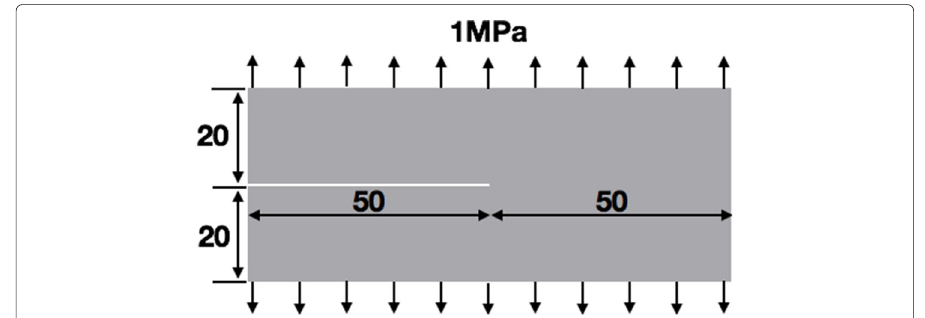
and Bobaru 2010; Borden et al. 2012) and therefore has a known solution. The material parameters used in this simulation are taken from (Borden et al. 2012) and are shown in Table 4. Also, plane strain is assumed. A uniform mesh with element size h = 0.25 mm is used.